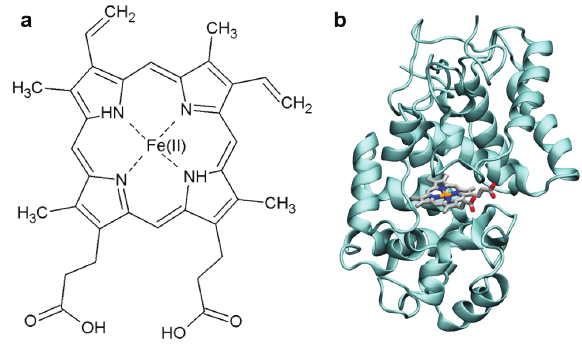
Figure 1: (a) Structure of haem or iron protoporphyrin IX (FePPIX) and (b) HRP with the haem cofactor highlighted. Possible axial ligands not shown for clarity. Protein structure generated using crystal structure data from the PDB